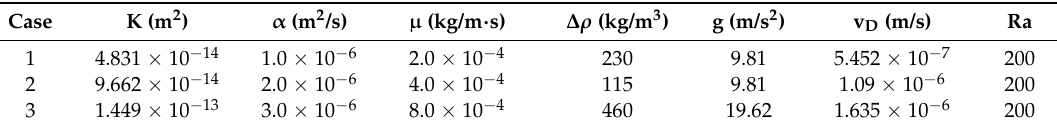
Table 1. Physical parameters of the first application.